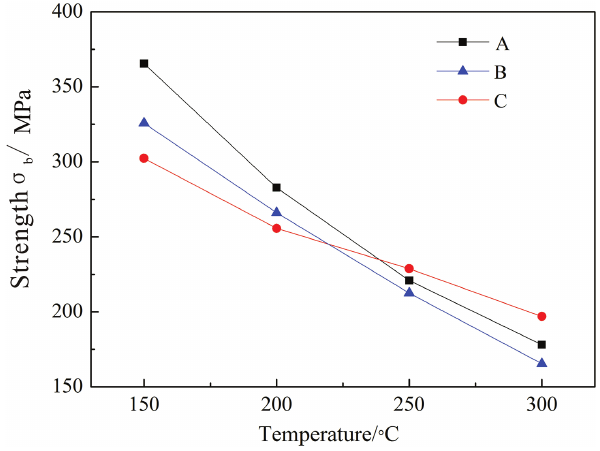
Figure 5: Tensile strength of alloy 2618-Ti with different grain size as a function of temperature.